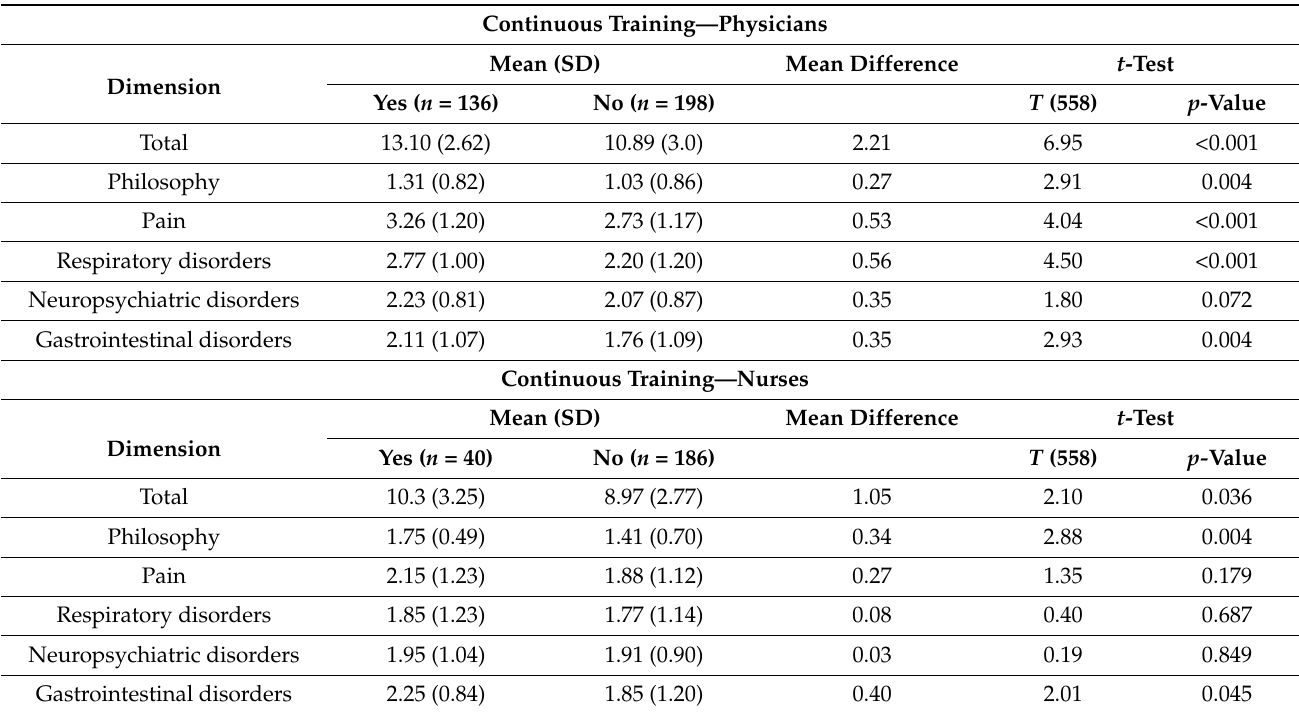
Table 4. Descriptive study and comparison of scores on PCKT-SV according to continuous training in palliative care in physicians and nurses.